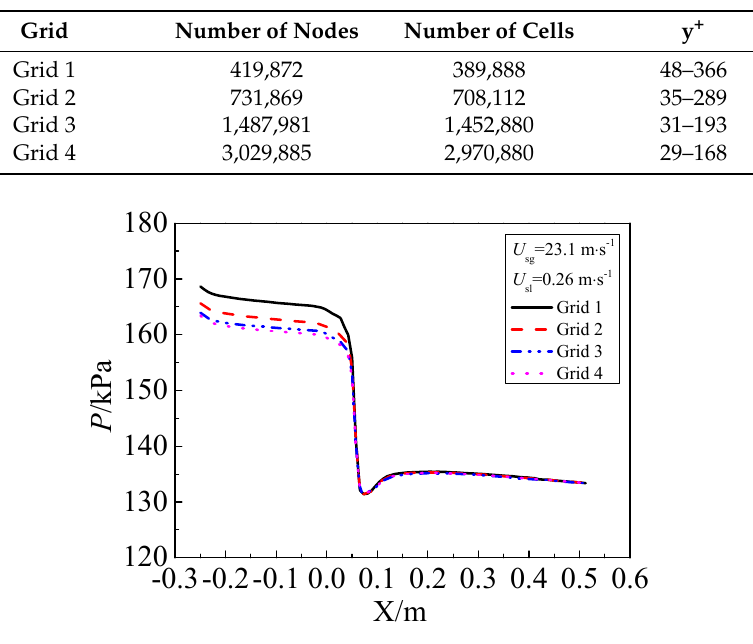
Figure 6. Wall pressure profiles under different grids. Table 5 . Wall pressure and its changes with different grids.